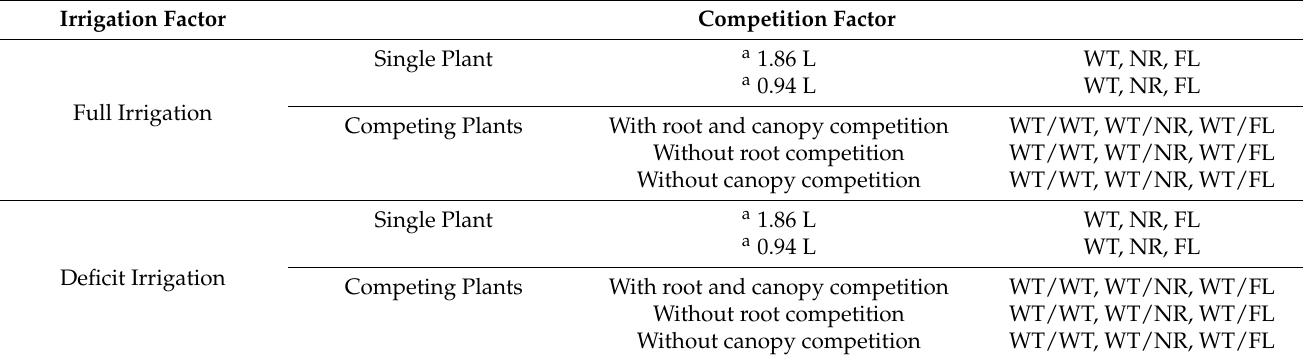
Table 1. Experimental design in this study. WT-wild type, NR-never ripe mutant, FL- flacca mutant. Irrigation Factor Competition Factor